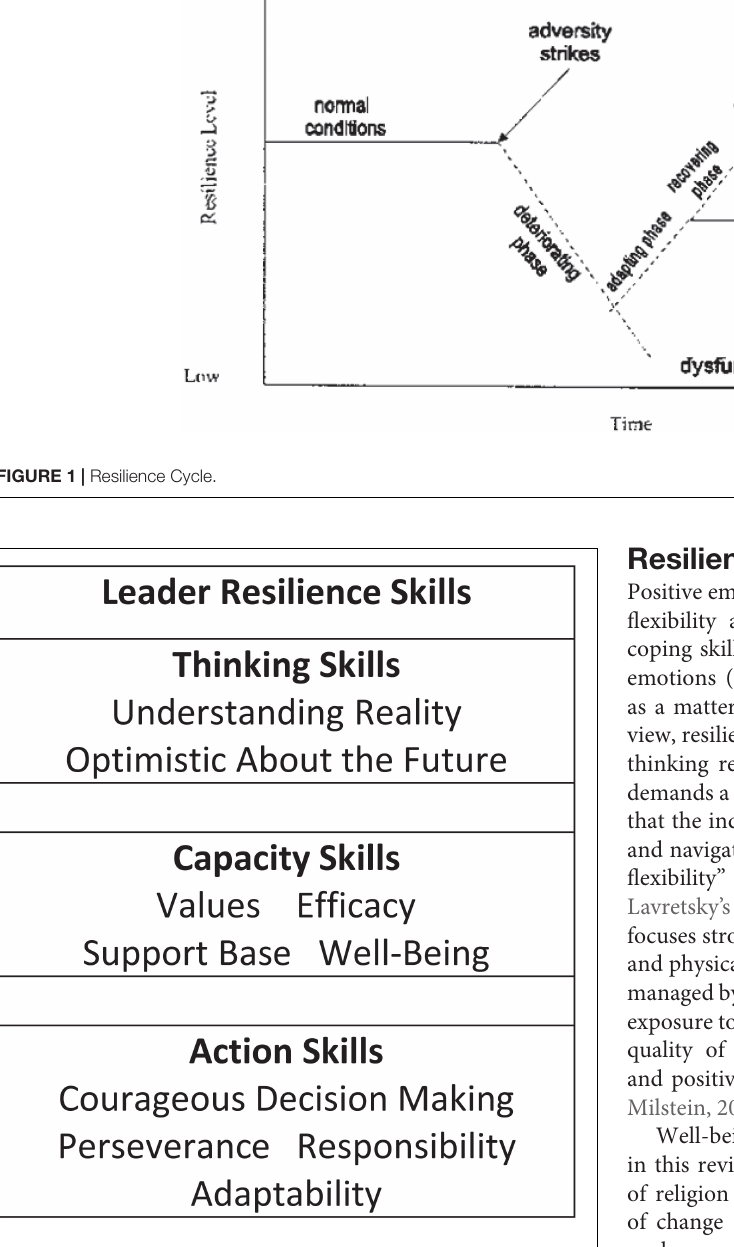
FIGURE 2 | Leader resilience